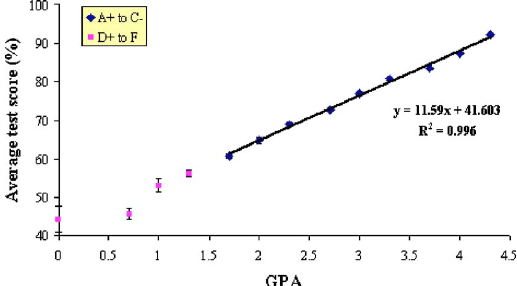
FIG. 2. (cid:1) Color (cid:2) Graph of students’ average total semester test score binned by their grade point average. Data are taken from the calculus-based E&M course from the 2003